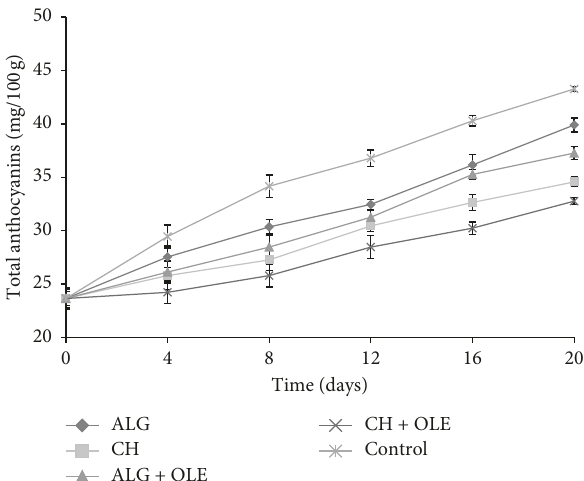
Figure 3: Changes in total anthocyanins expressed as mg cyanidin- 3-glucoside equivalent per 100g fresh weight of the sample. ALG: 3% alginate, CH: 1% chitosan, ALG +OLE: 3% alginate +1% olive leaves extract (OLE), CH +OLE: 1% chitosan+ 1% OLE, and control: distilled